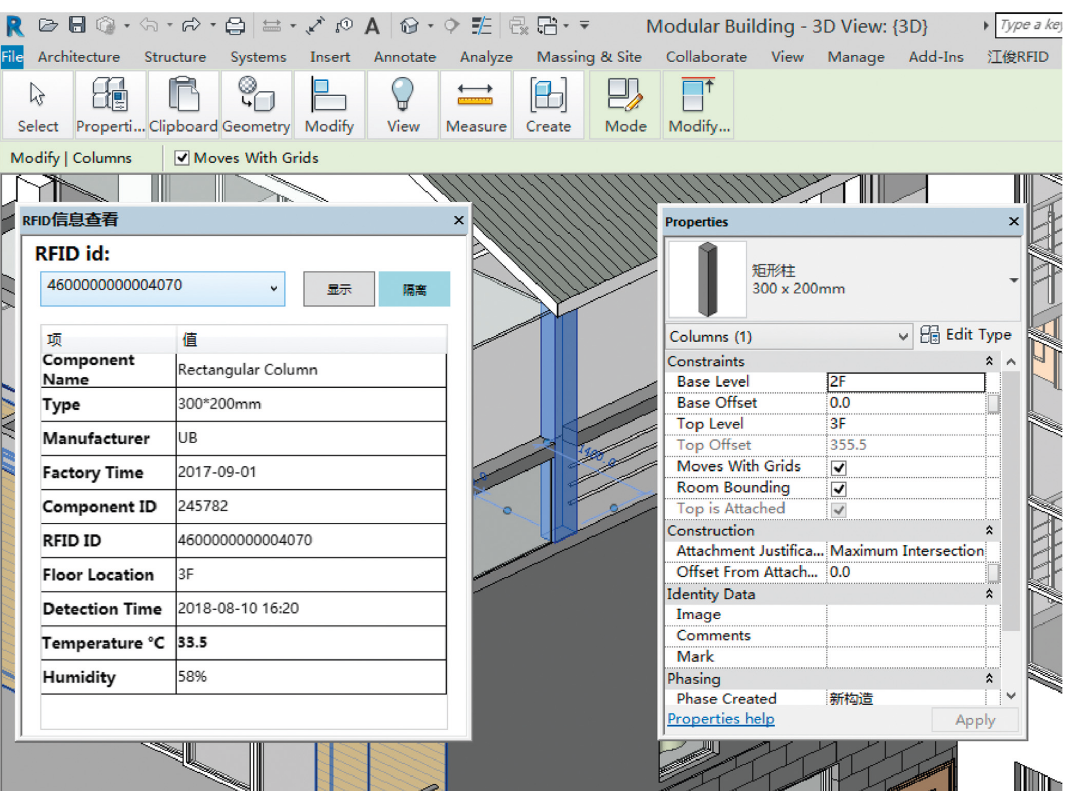
Figure 10: Visualization of prefabricated component